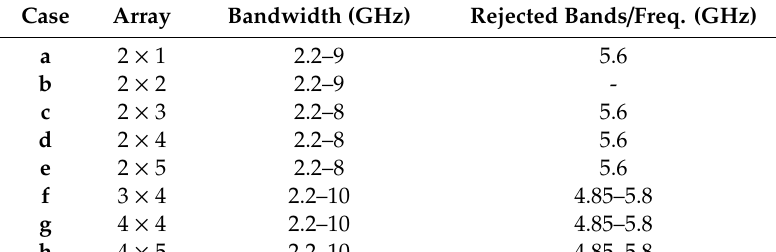
Figure 40. S 11 for different S-SRR arrays. Figure 41. Antennas maximum gain with different S-SRR arrays.